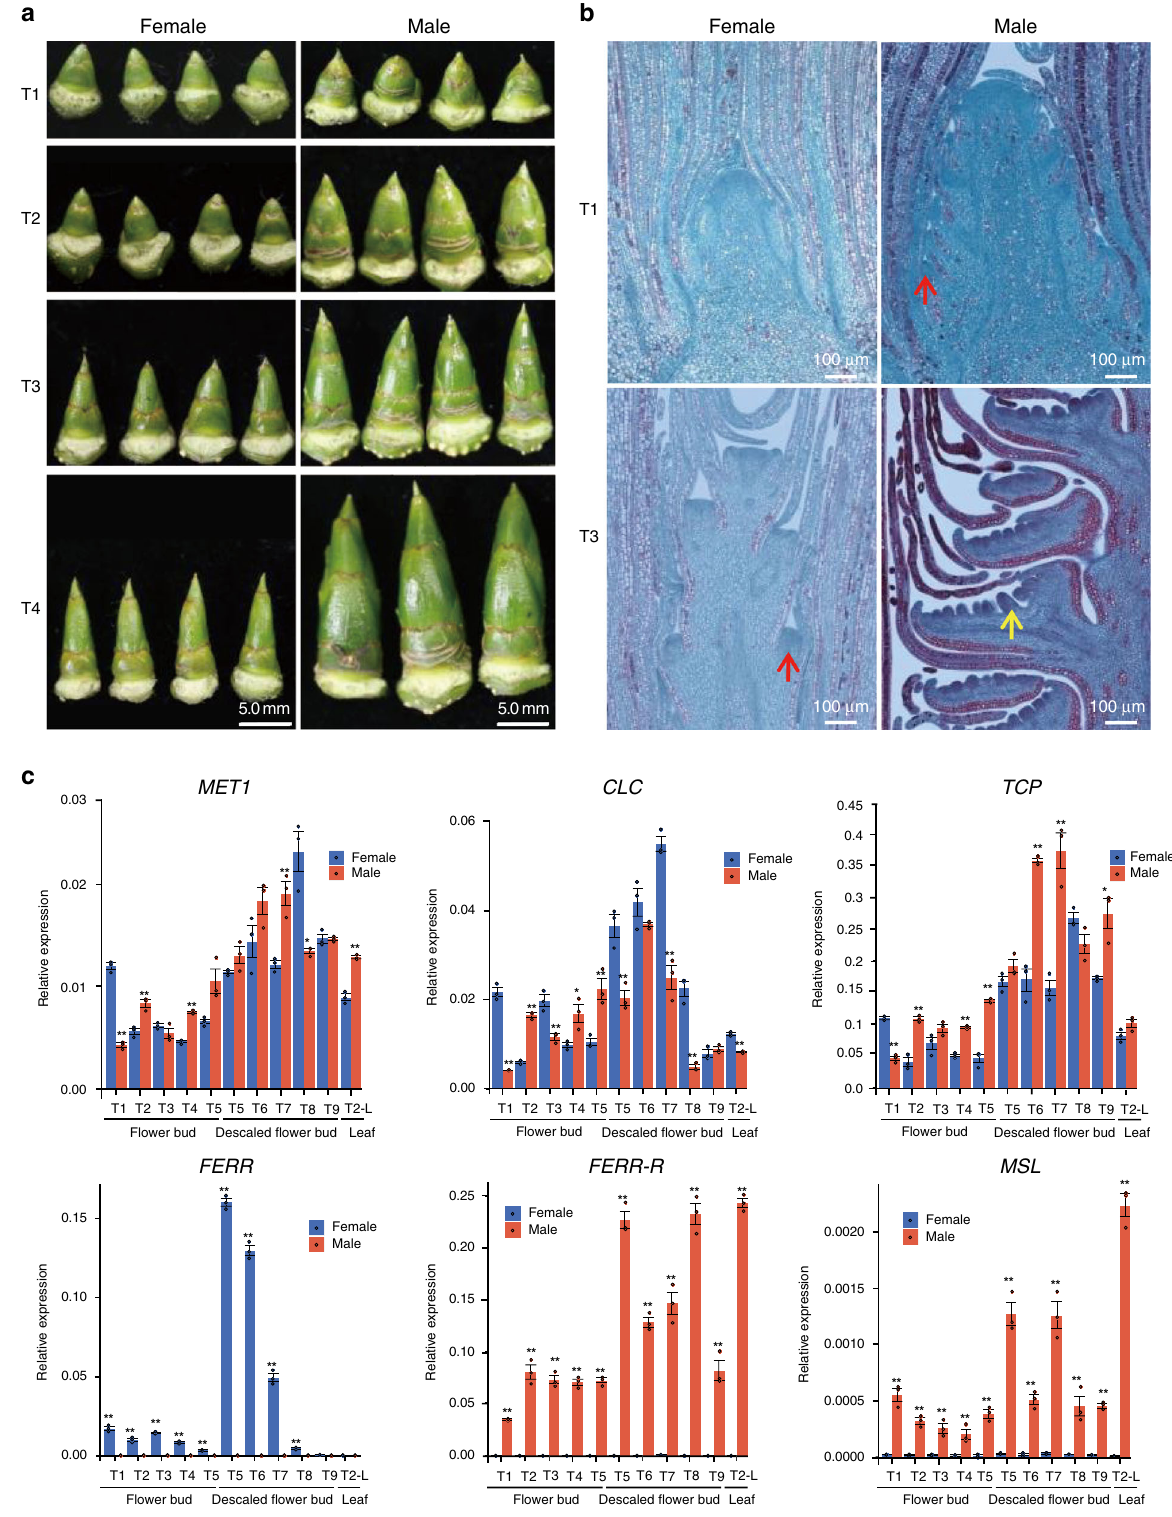
Fig. 3 Development of fl ower buds and gene expression pro fi les. a Morphology of the male and female fl ower buds at developmental stages T1 – T4 de fi ned in the text. b Longitudinal sections of male and female in fl orescences at T1 and T3. The red arrows point to the fl oret primordia, and the yellow arrow denotes the anther primordium. Three independent samples were observed with similar results. c Gene expression pro fi les in the 8 fl ower development stages described in the text. Values shown are the mean ± SD from three biological replicates (* P < 0.05; ** P < 0.01, two-sided Student ’ s t test). The data for c are provided as a Source Data fi